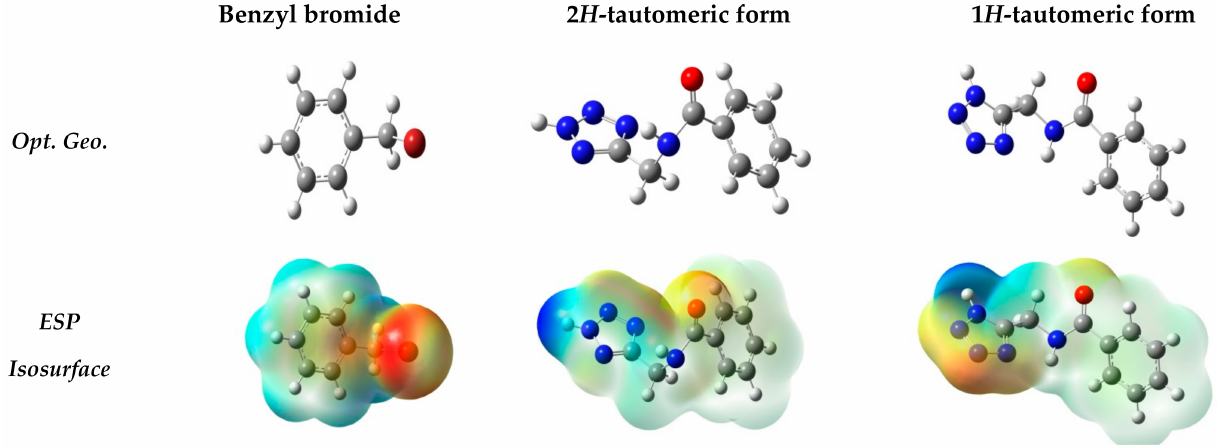
Figure 4. The optimized geometry and representations of electrostatic potential (Isosurface) of the studied compounds.